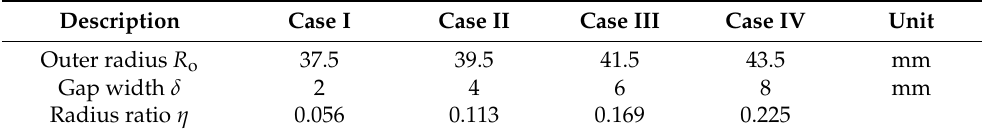
Figure 3. Schematic diagram of Saari’s experimental apparatus [23]. Table 1. Dimensions of outer radius R o , gap width δ , and radius ratio η